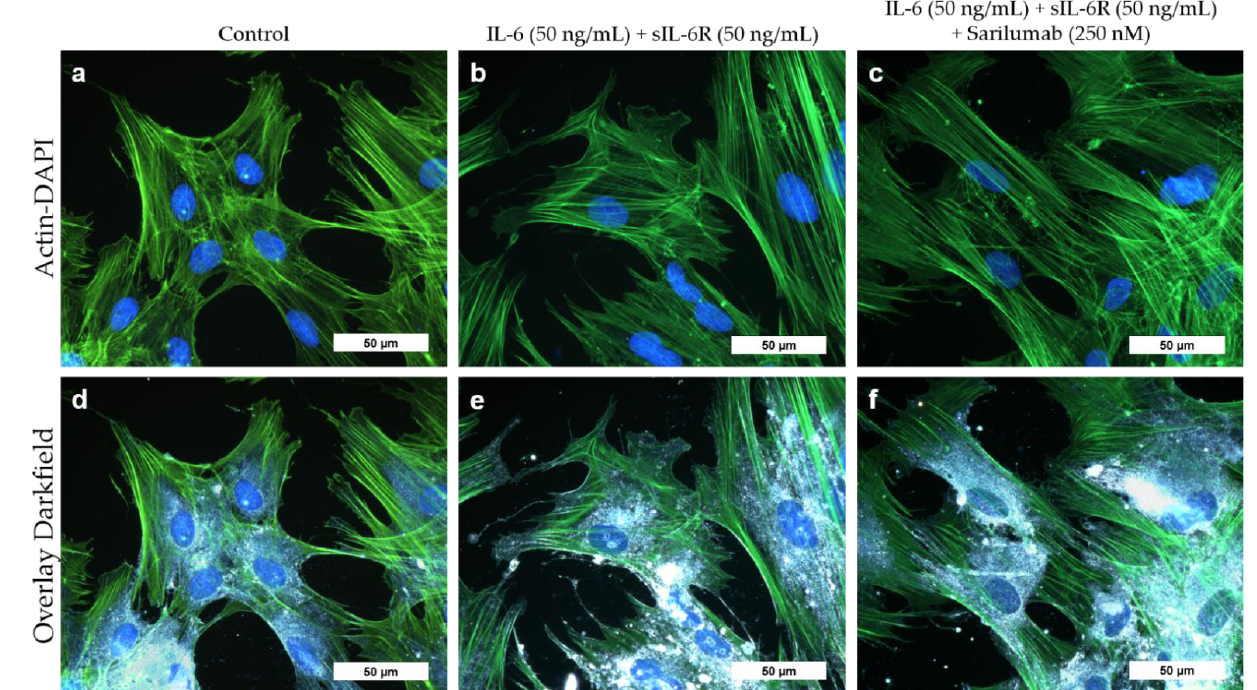
Figure 3. Cell morphology of human osteoblasts (passage 3, male donor, 68 year) after exposure to IL-6, sIL-6R ± sarilumab for 72 h. ( a – c ) Fluorescence stain of the actin cytoskeleton (green fluorescence) and cell nuclei (blue fluorescence). ( d – f ) Overlay of the stained actin cytoskeleton, nuclei, and enhanced darkfield microscopy to visualize intra- and extracellular structures. Bar: 50 µm.